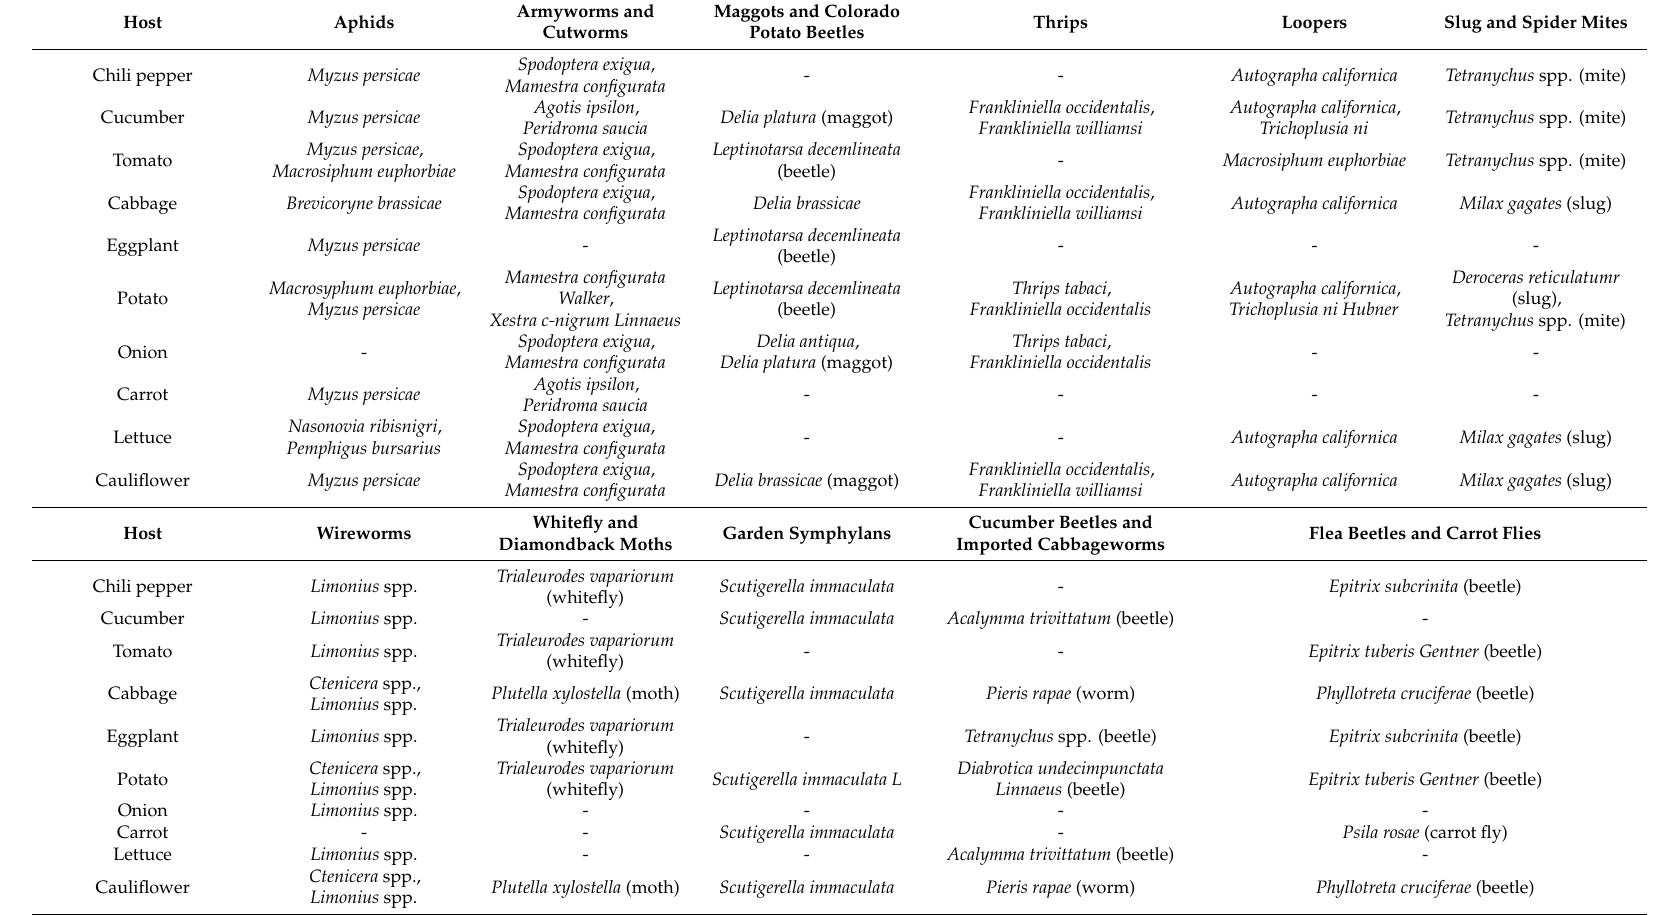
Table 4. Common vegetable crop